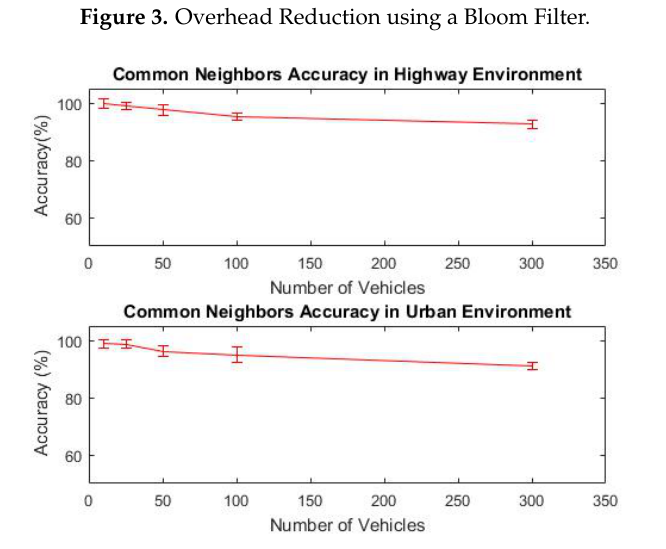
Figure 4. Common neighbors